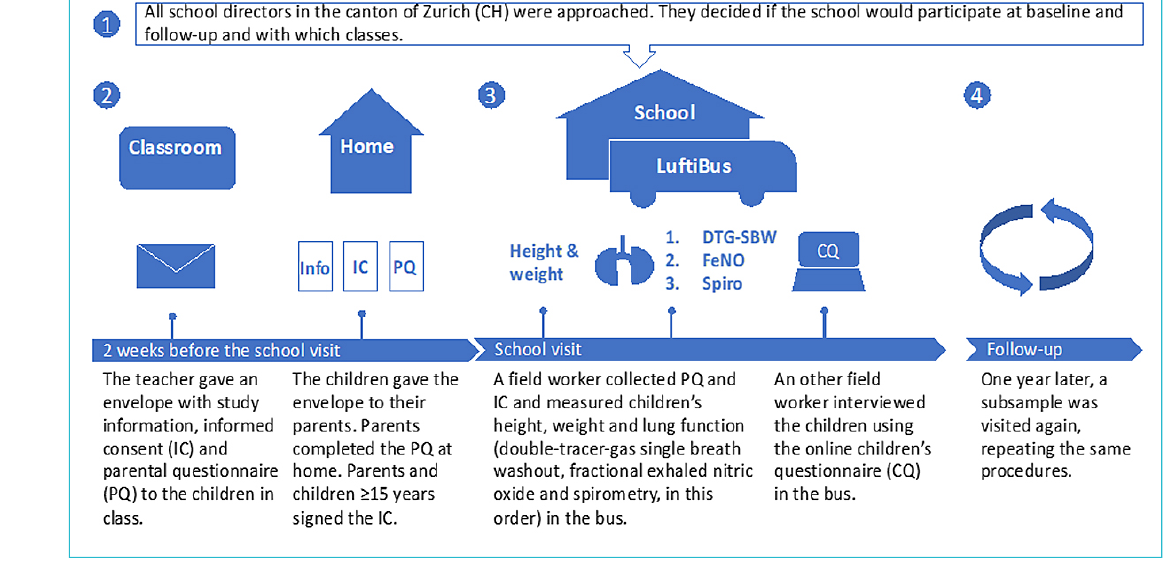
Figure 1: Design of the LuftiBus in the school (LUIS)